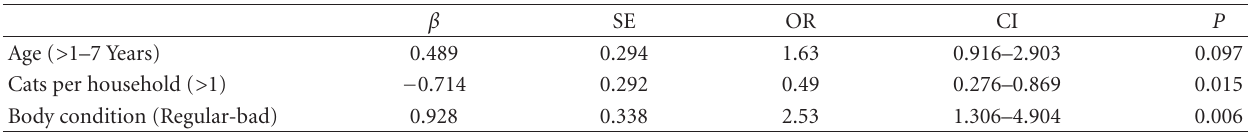
Table 2: Binomial logistic regression to evaluate the association between studied variables and T. gondii infection cases from chronically reactivated cats. Chronically reactivated cases (positive to IgM, IgG, and PCR).